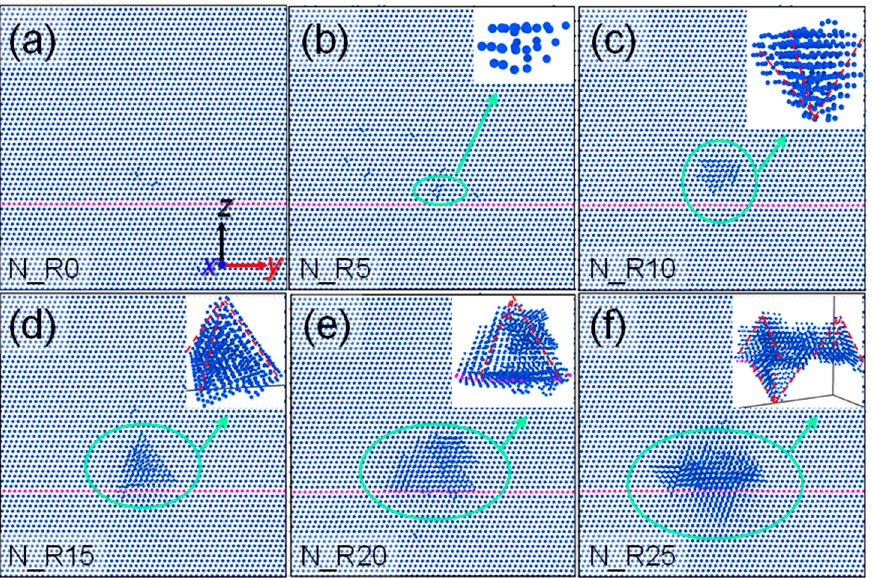
Figure 7. Snapshots of the six pure Ni models extracted from the ending moment of cascades. ( a ) N_R0. ( b ) N_R5. ( c ) N_R10. ( d ) N_R15. ( e ) N_R20. ( f ) N_R25. SFT-like structures are labeled.